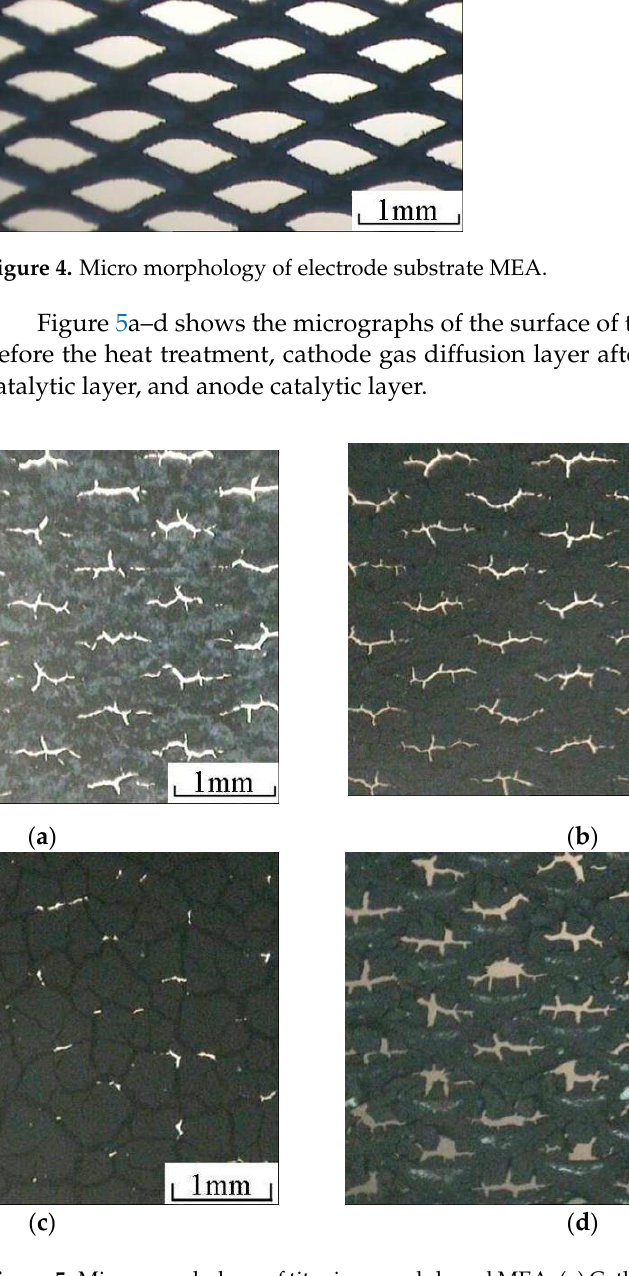
Figure 5. Micro morphology of titanium mesh-based MEA: ( a ) Cathode gas diffusion layer before heat treatment; ( b ) cathode gas diffusion layer after heat treatment; ( c ) cathode catalytic layer; ( d ) anode catalytic